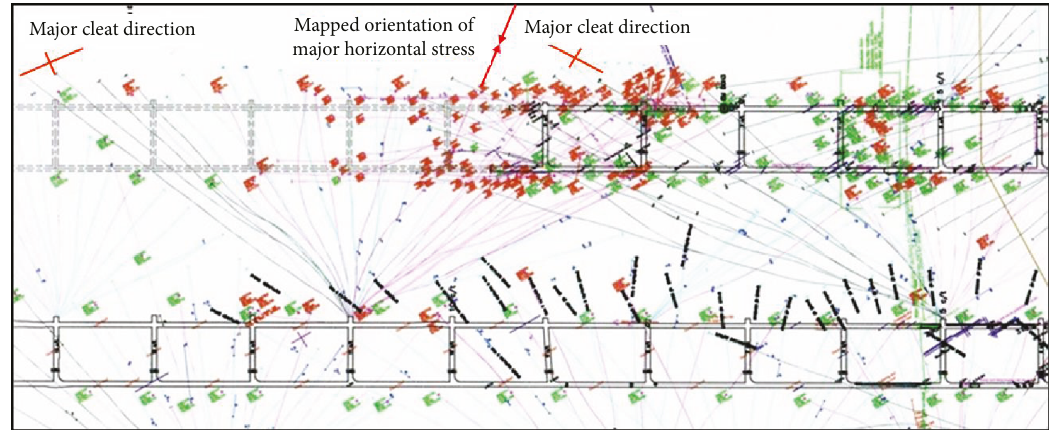
Figure 4: Mine plan picture of typical hard-to-drain areas showing the gas drainage borehole layout (Ref. [45]).